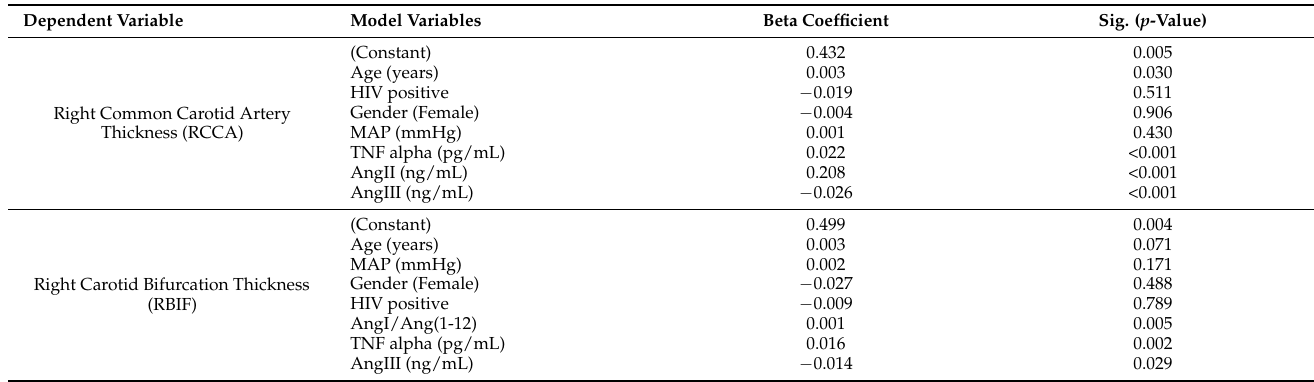
Table 6. Multivariate linear regression model for biomarkers associated with carotid